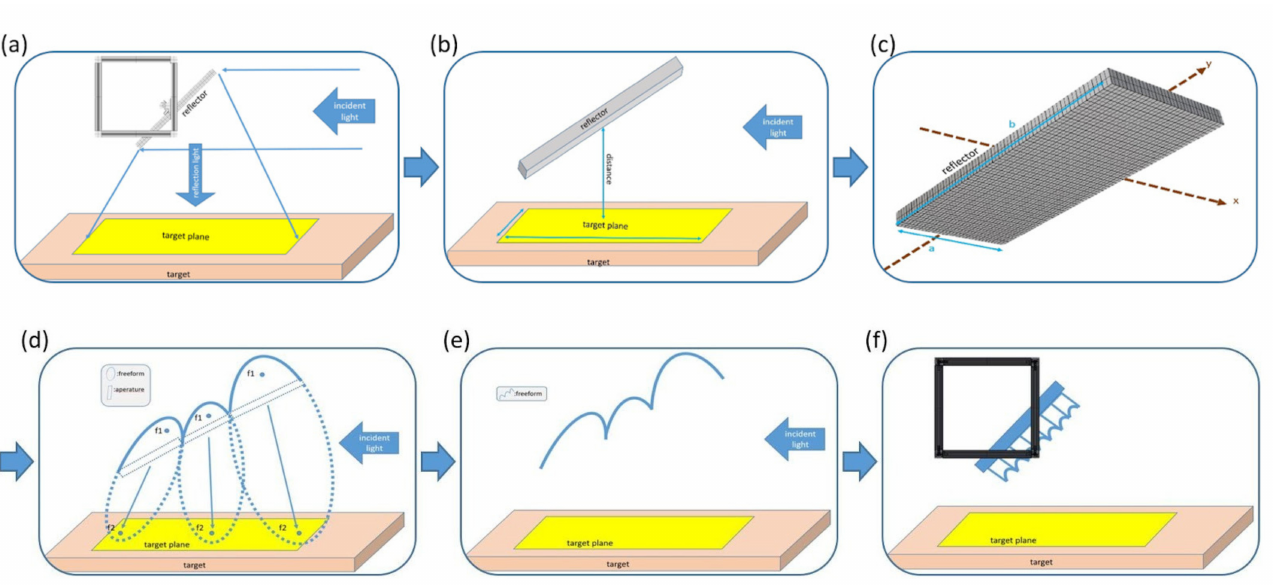
Figure 13. Optical module design for the following: ( a ) defining the coordinates of the reflector plane; ( b ) measuring the size of the target plane and the distance between the reflector and the target plane; ( c ) determining the number of segments (in ( a ) and ( b ), respectively) along the x / y axes; ( d ) making every facet ellipsoid with the size of the element (schematic sketch; the elements of the facetted reflector had sizes of 3 mm × 3 mm); ( e ) eliminating the excessive part; and ( f ) converting freeform surfaces to solids.